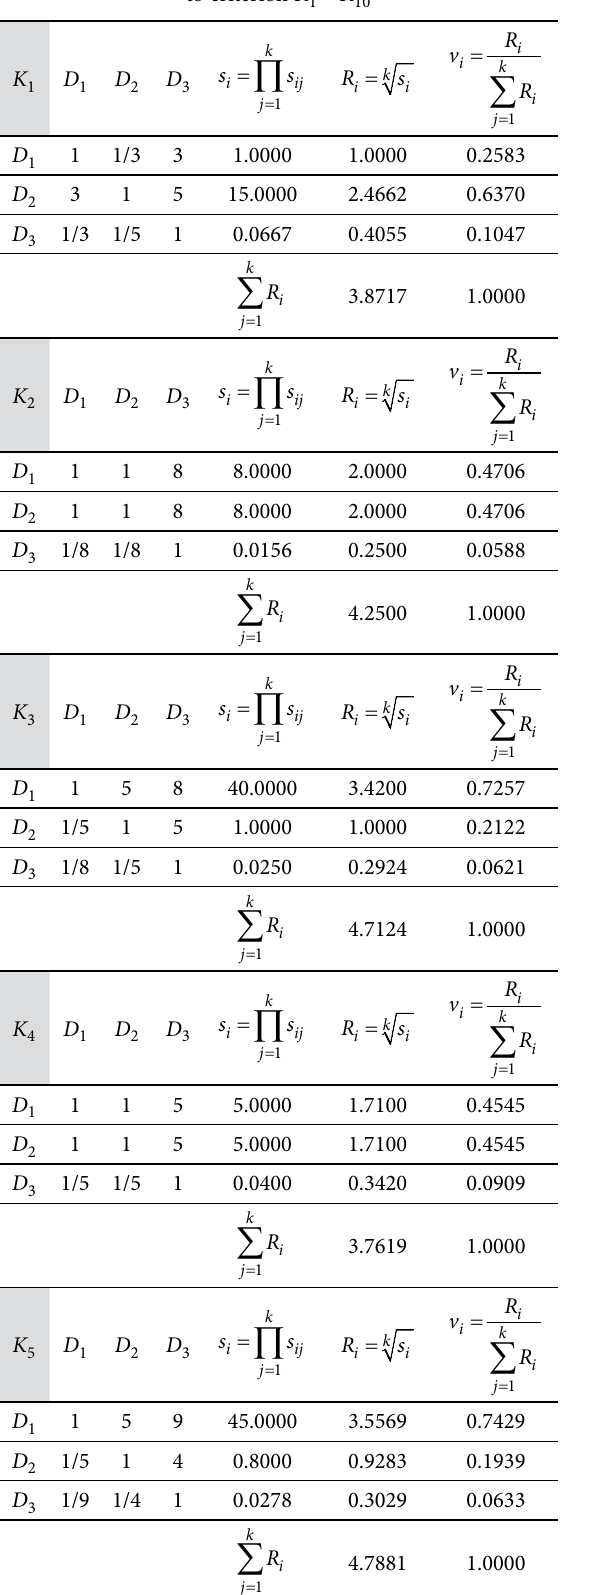
Table 5. Matrix of weights for three possible suppliers due to criterion K 1 – K